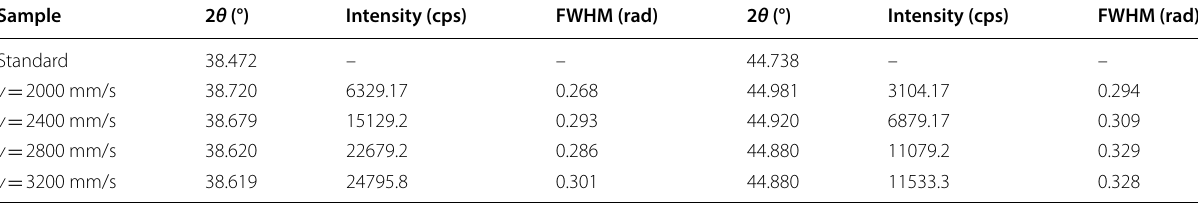
Table 1 Variation of 2θ locations and intensities of the α-Al diffraction peaks in SLM-processed composites with different